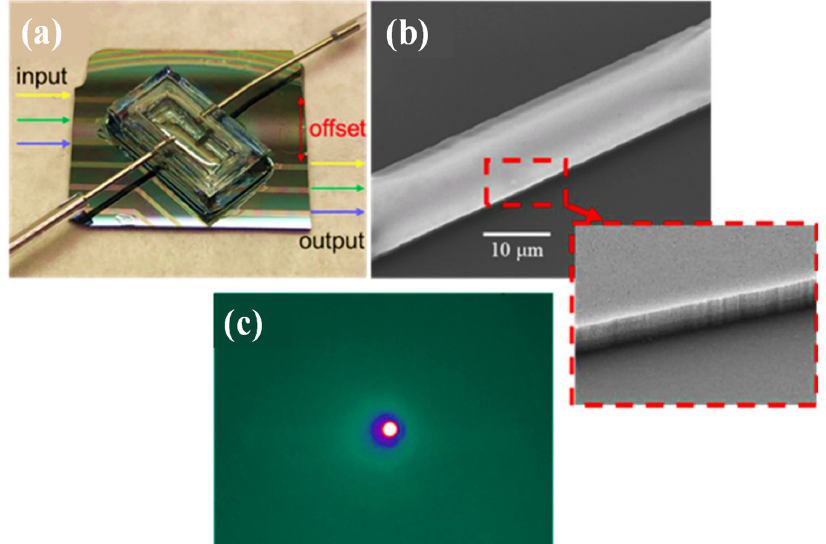
Figure 8. ( a ) Sensor device with PDMS chamber and SiN waveguides. Waveguides for the input and output had a 5 mm offset [132], ( b ) SEM image of the waveguide and inset shows the side wall [132], ( c ) near-field pattern of the fundamental mode [132].